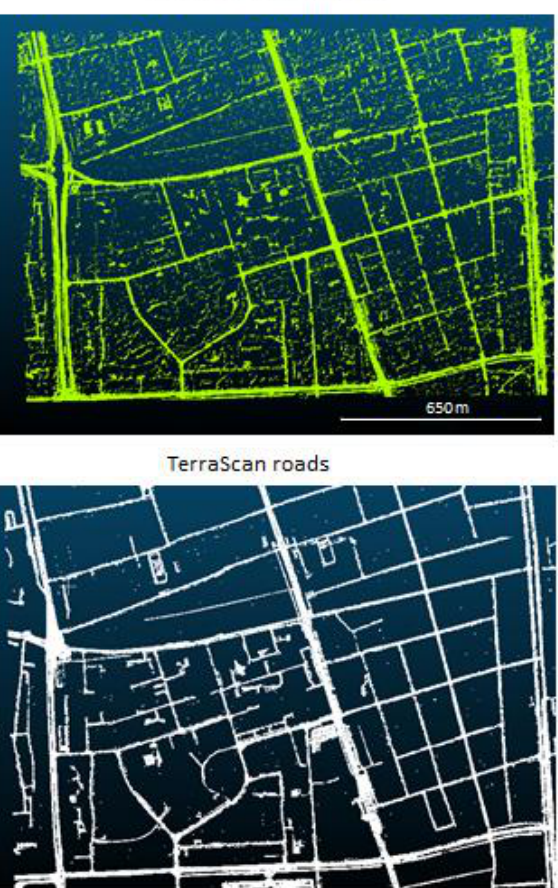
Fig. 4 Visual comparison of single- and dual-wavelength classification based on radiometric information